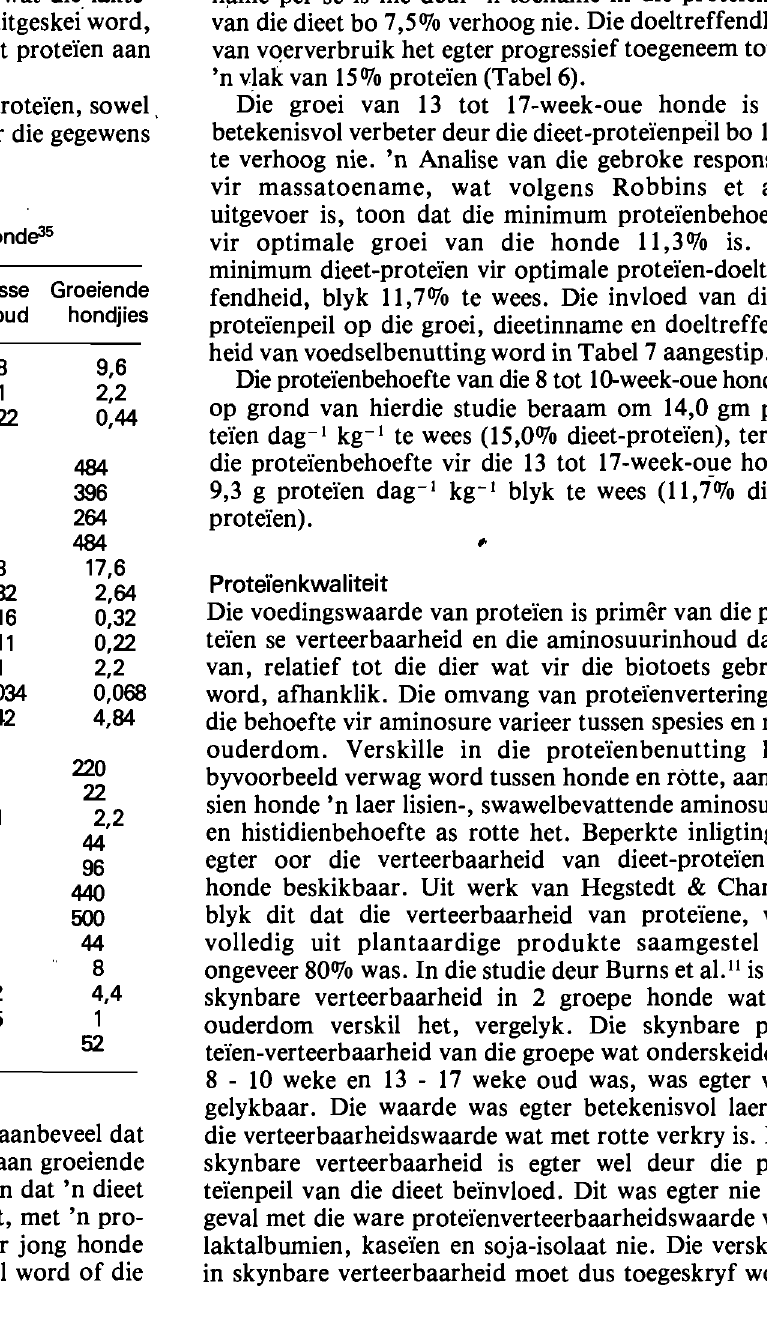
Tabel5: Aanbevole nutrientpeile vir honde3 5